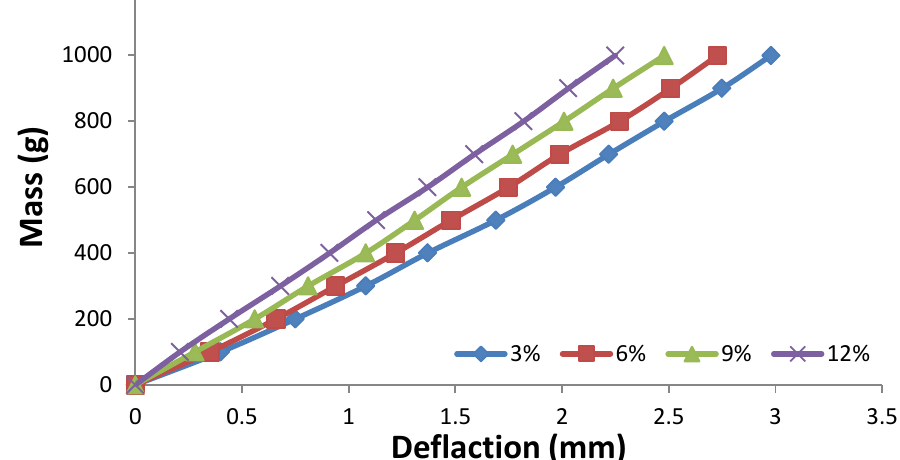
Fig. 5: Mass vairation with different concentrations of SiO sulfuric acid for 10